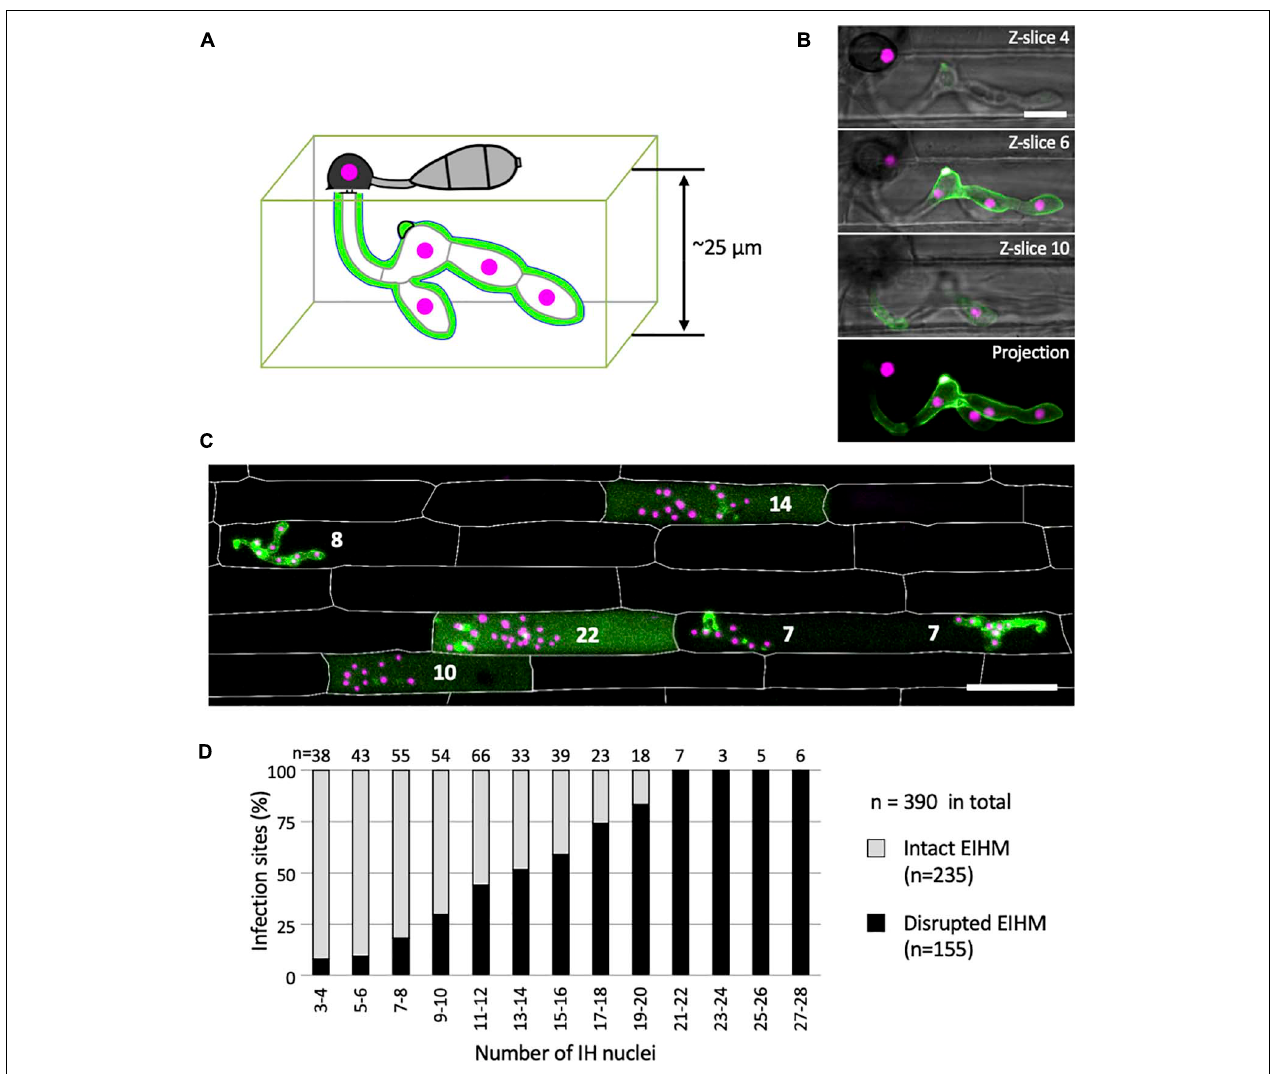
FIGURE 4 | The occurrence of EIHM disruption increases proportionally with nuclear stage. (A) Schematic diagram three-dimensionally depicting an epidermal rice cell invaded by M. oryzae expressing sec-GFP (green) and nuclear tdTomato (magenta). (B,C) Confocal images of rice cells invaded by M. oryzae CKF2187 expressing sec-GFP (green) and nuclear tdTomato (magenta). (B) Images of the same infection taken at different focal planes. The top three panels show merged fluorescence and bright-field from individual focal planes (indicated in the top right corner), while the last panel shows a merged fluorescence projection of all focal planes; 12 z-slices in total spanning 24 µ m over the z-axis. Note that all five fungal nuclei are fully visible only in the projection view. Bar = 10 µ m. (C) A merged fluorescence projection of infected rice cells at 30 hpi showing different patterns of sec-GFP localization at different IH growth stages determined by the nuclear number for each infection (white numbers). The infection to the far left shows EIHMx-localized sec-GFP (intact EIHM), while the other infections show host-localized sec-GFP (disrupted EIHM). Note the infected rice cell at the bottom right was invaded by two separate appressoria. Rice cell walls are indicated by white outlines. Bar = 50 µ m. (D) A plot of the frequency of EIHM disruption according to fungal nuclear number for 390 infections of M. oryzae CKF2187 in the first-invaded host cell between 28 and 33 hpi. Sec-GFP localization patterns revealed the distribution of intact ( n = 235) and disrupted ( n = 155) EIHMs (y-axis) at each group of two nuclear stages